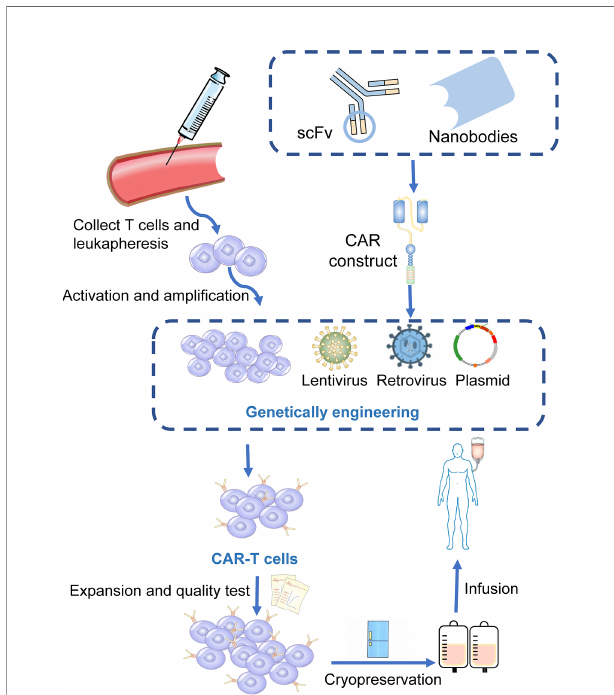
FIGURE 1 | Manufacturing procedures of CAR-T cells. T cells are fi rstly collected from the peripheral blood of the patients. The activated and ampli fi ed T cells are genetically engineered with CAR structure via retroviral, lentivirus or other vectors. CAR-T cells are then expanded ex vivo and a quality control procedure is applied. Finally, those modi fi ed T cells were infused back into the